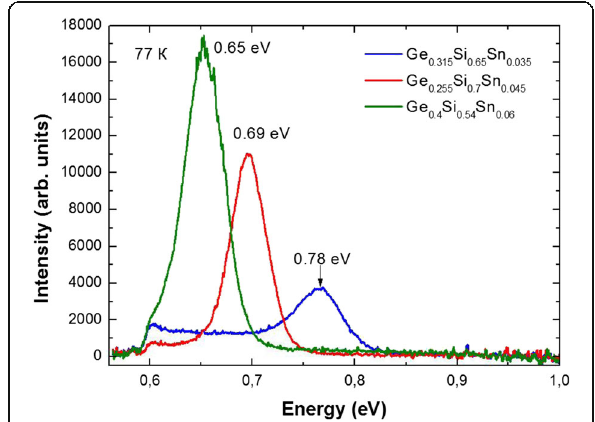
Fig. 7 The photoluminescence spectra from multilayer periodic structures with the 3.5, 4.5, and 6% Sn content in the pseudomorphic GeSiSn